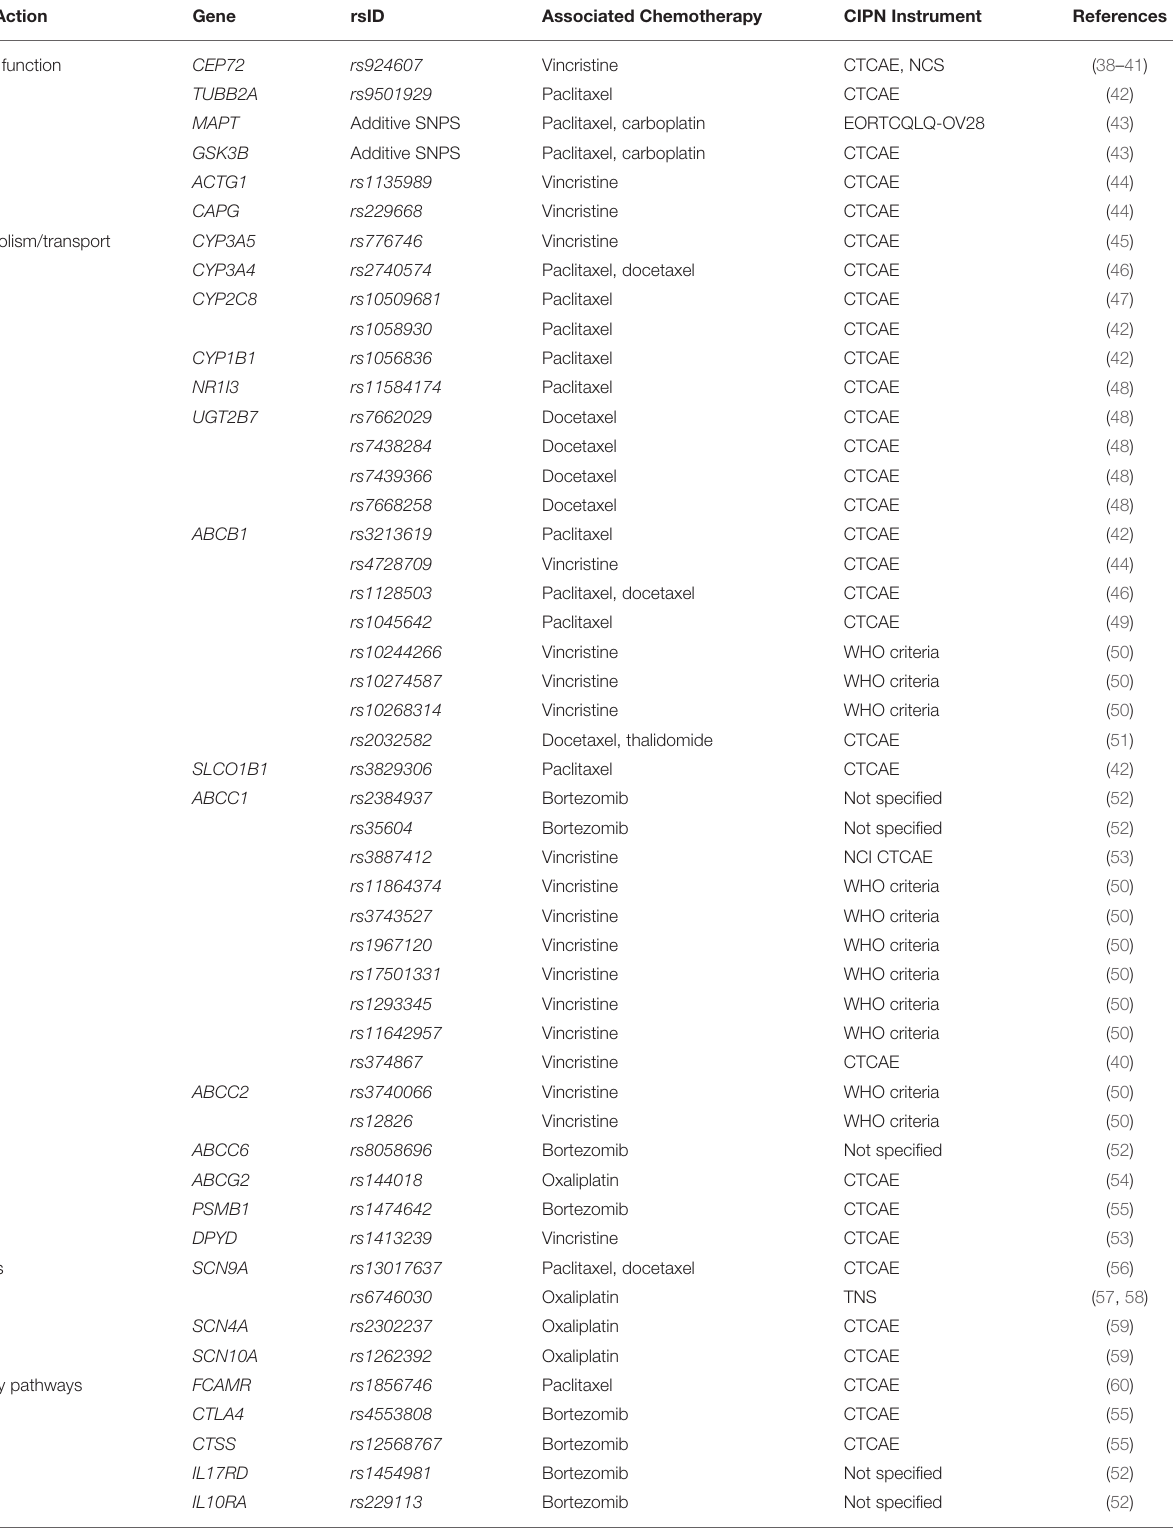
TABLE 1 | SNPs associated with CIPN